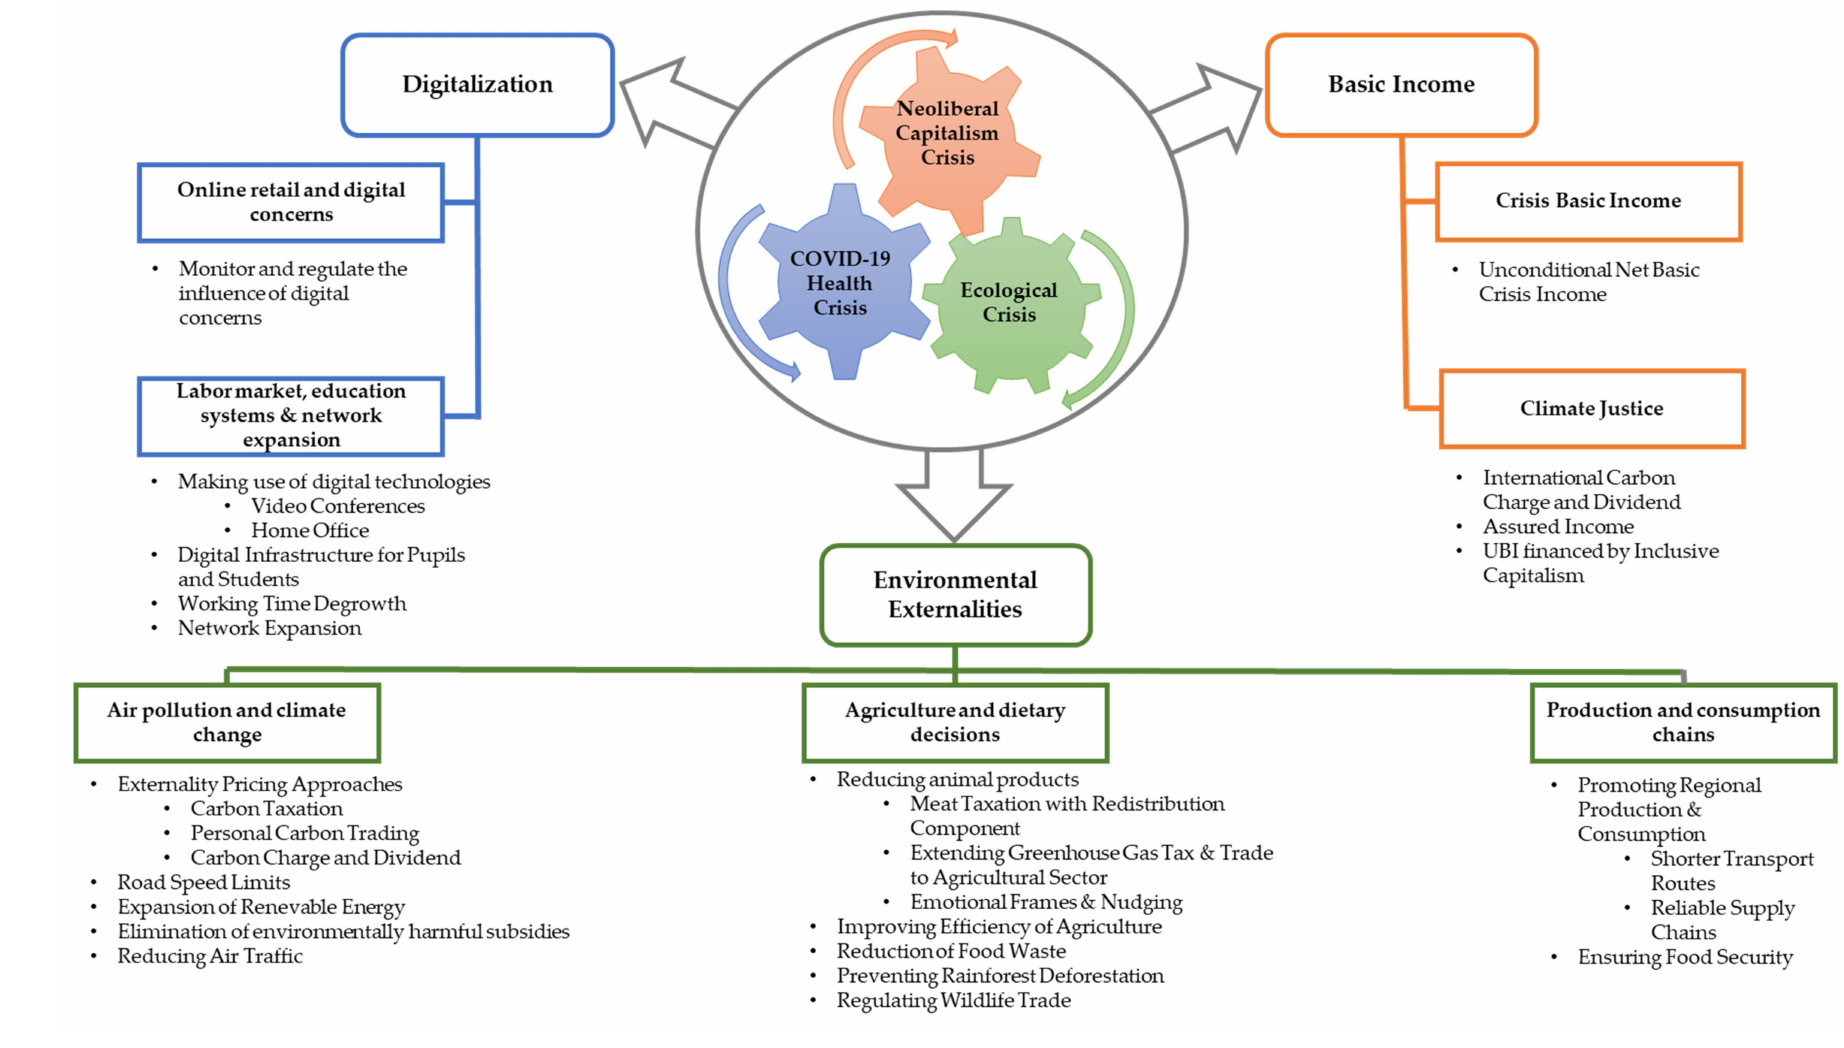
Figure 4. Implications from the three globalization crises. Own